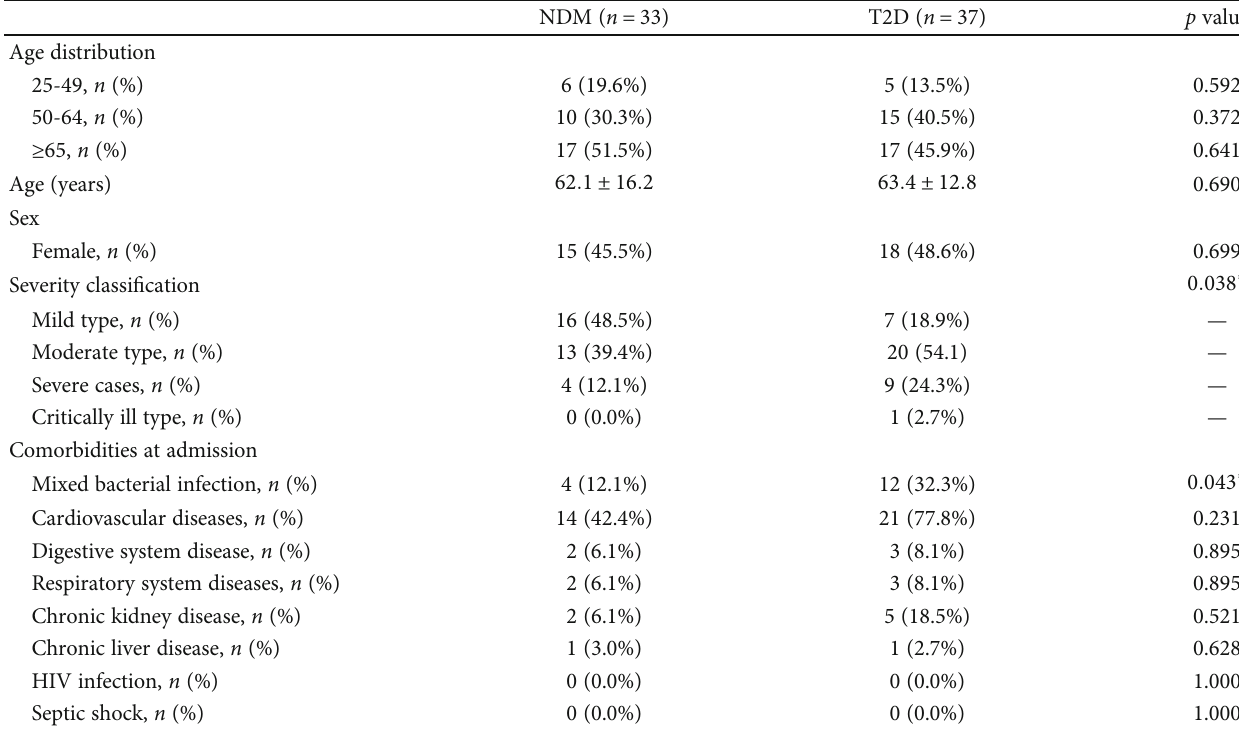
Table 1: Basal characteristics of patients infected with COVID-19.